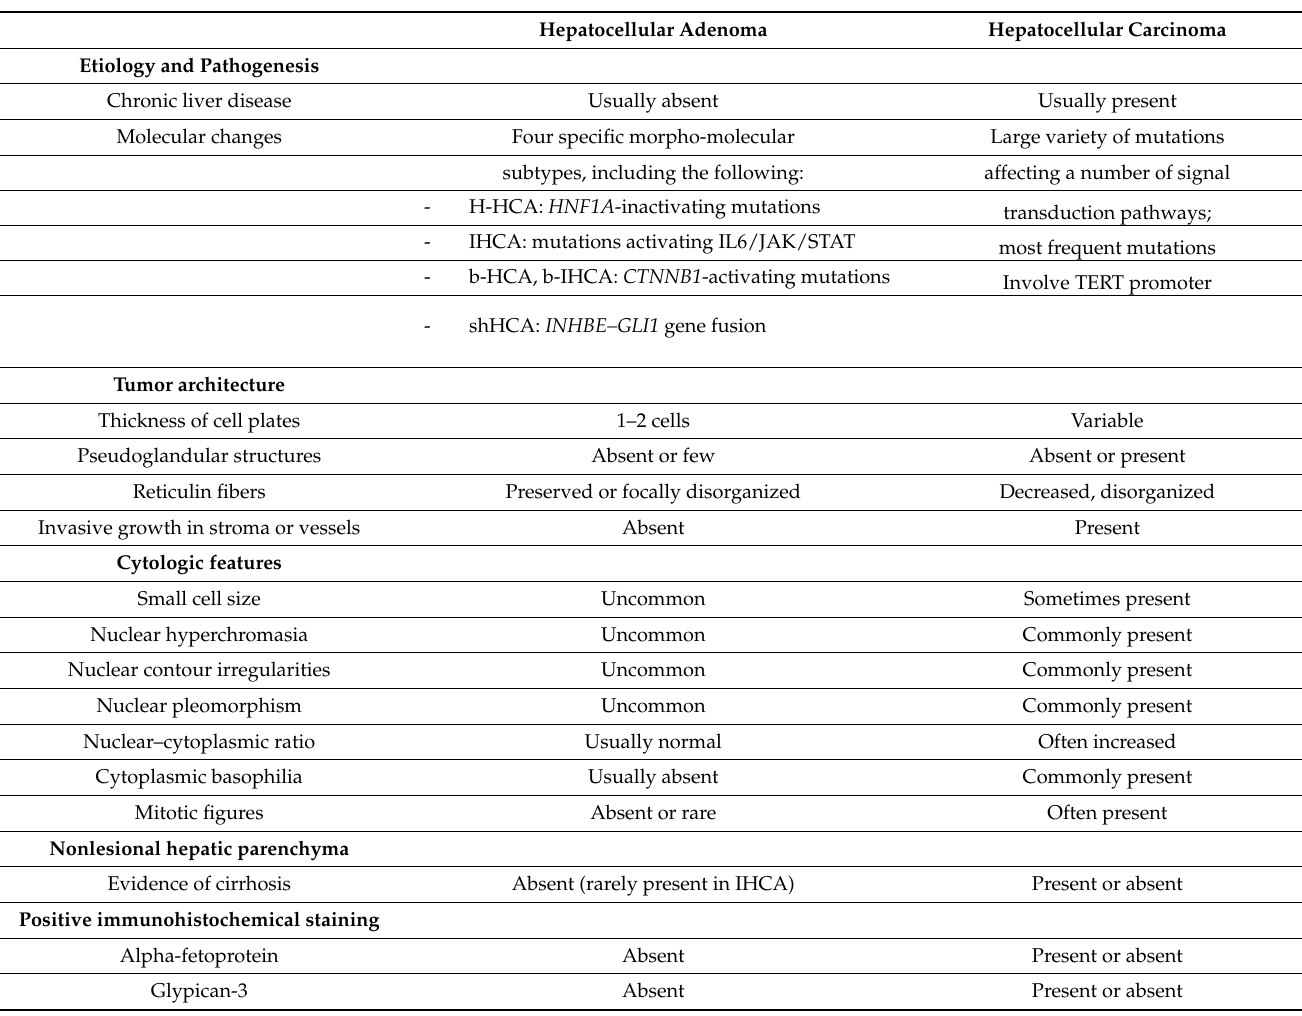
Table 1. Comparison of etiology, pathogenesis, and diagnostically useful histopathologic features of hepatocellular